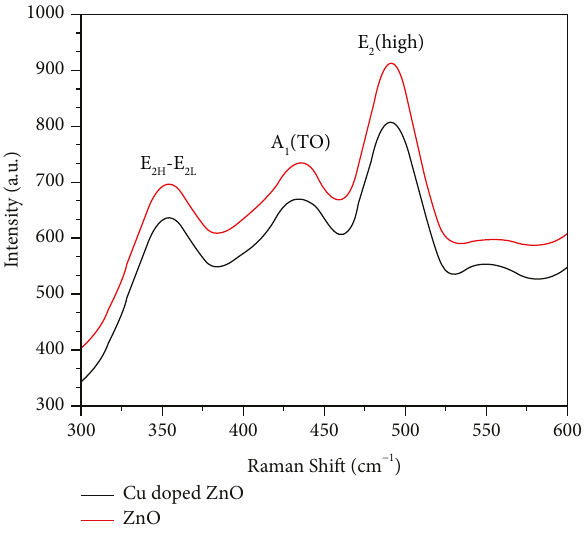
Figure 4: Raman spectroscopic study of undoped and Cu-doped ZnO NPs.